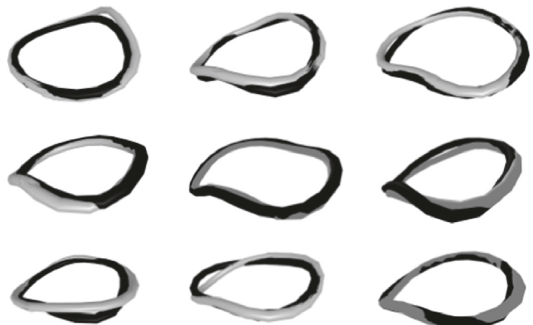
Figure 7: Mitral valve annulus curves for nine randomly selected patients of the test dataset. The manually detected and the predicted curve are displayed in gray and black, respectively.